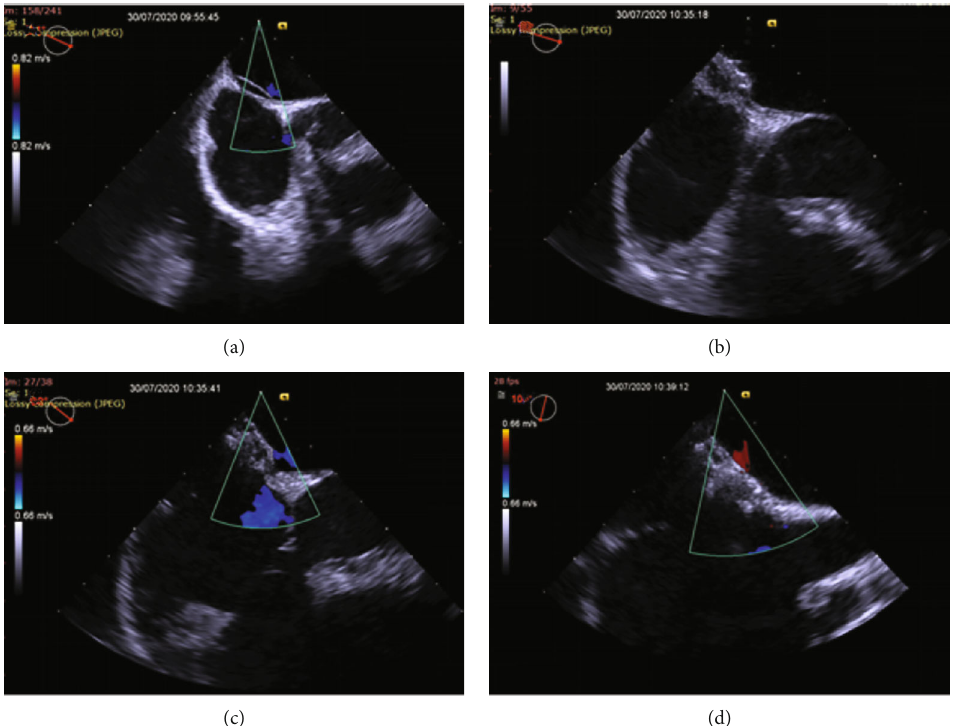
Figure 2: (a) TEE revealing a long-tunneled PFO. (b – d) TEE showing the fi nal position of Cardia Ultrasept PFO 20 mm device, with no residual leak.